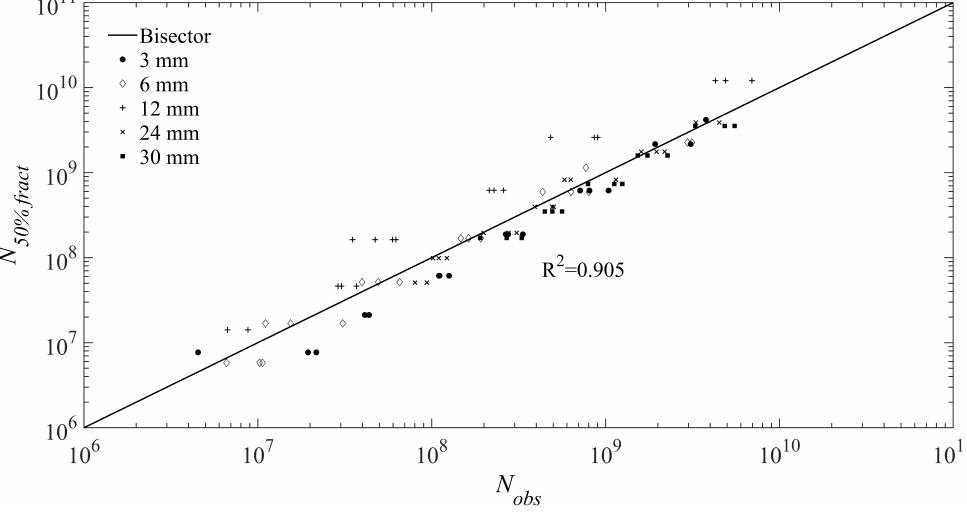
Figure 8. Median fatigue life predicted by the fractal model ( N 50% fract ) versus the experimentally observed number of cycles ( N obs